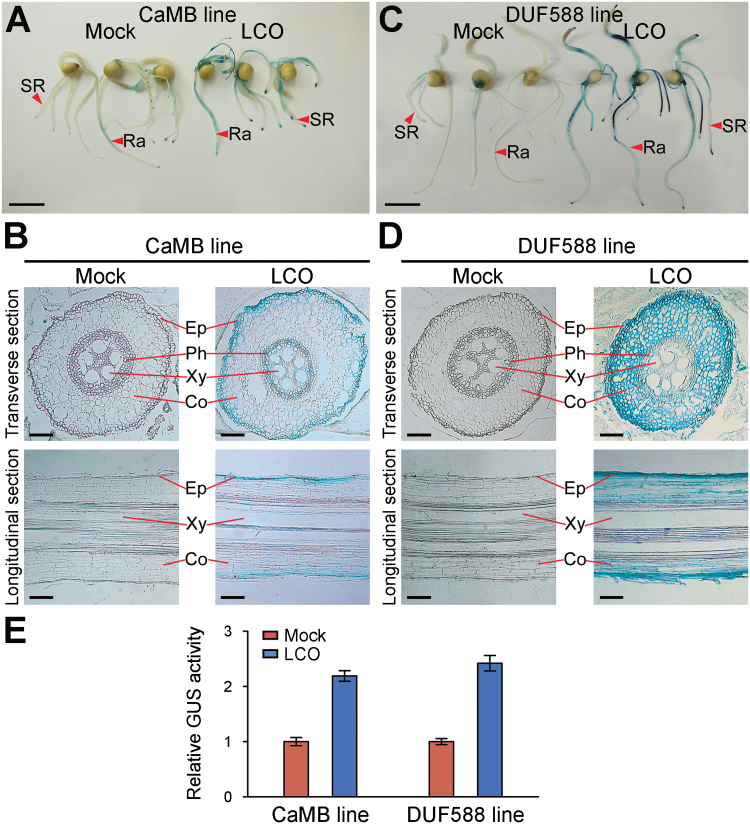
LCO increased promoter activities of LCO-up-regulated genes. (A-D) The expression of pCaMB::GUS and pDUF588::GUS constructs were shown by histochemical GUS staining in the LCO-treated transgenic maize seedlings in A and C and in transverse and longitudinal seminal root section in B and D. (E) Biochemical GUS assay in the protoplast from the root tissues (n = 5). Co, Cortex; Ep, Epidermis; Ph, Phloem; Ra, Radicle; SR, Seminal root; Xy, Xylem. Scale bars=2cm (A, C), 100 μm (B, D).